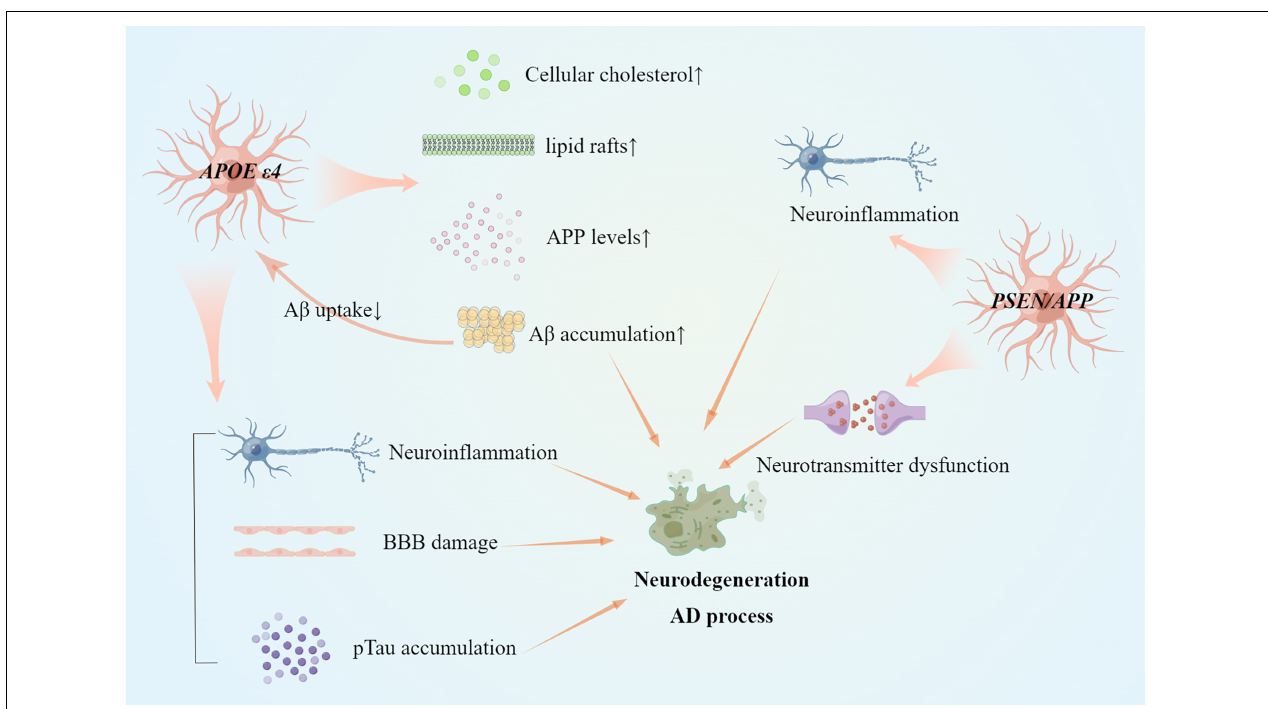
FIGURE 2 | Reactive astrocytes in gene variants of AD and AD pathogenesis. Several mechanisms have changed in astrocytes with APOE ε 4 allele or PSEN / APP variant. Both APOE ε 4 allele and PSEN / APP variant induce neuroinflammation by pro-inflammatory factors. Cholesterol dysfunction remains in reactive astrocytes with APOE ε 4 allele. Besides, reactive astrocytes with APOE ε 4 allele also accumulate A β and pTau protein aggregation, and BBB